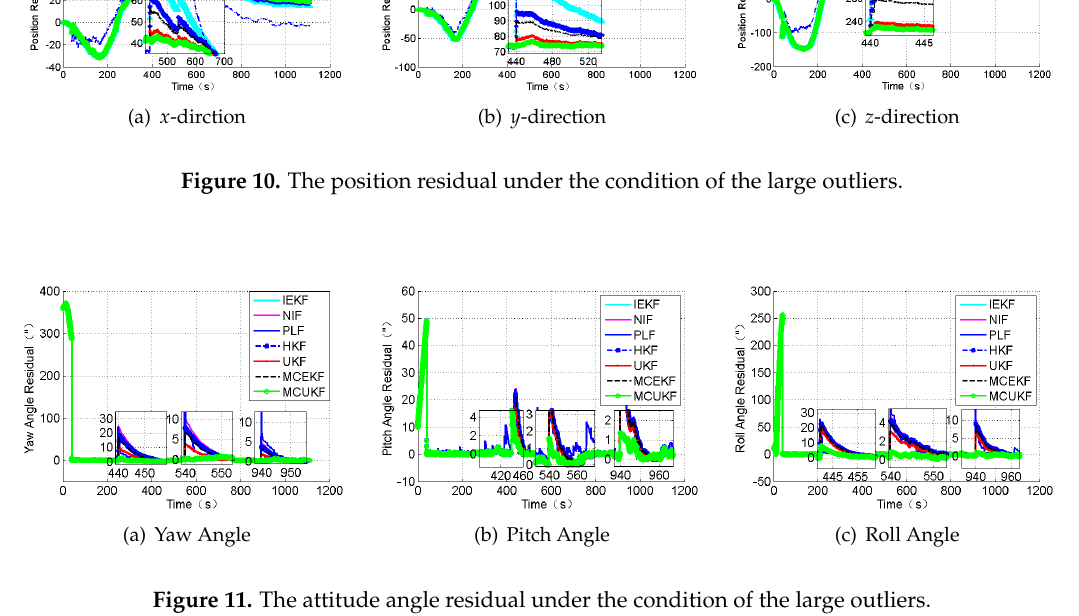
Figure 11. The attitude angle residual under the condition of the large outliers.